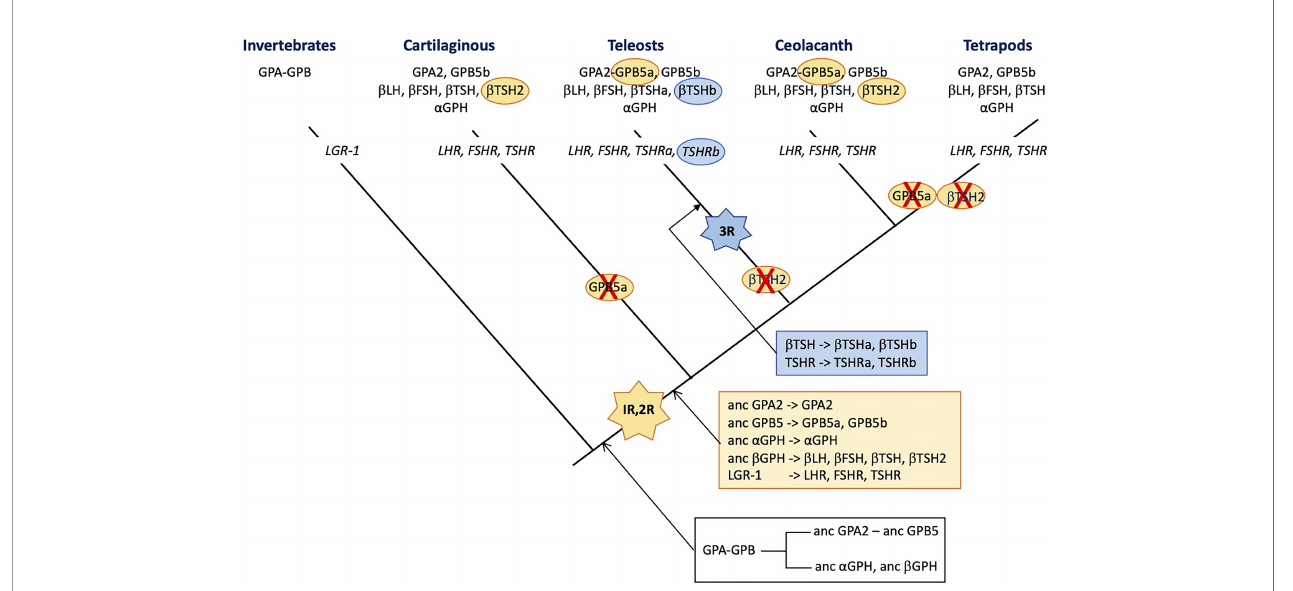
FIGURE 3 | Schematic representation of the distribution of glycoprotein hormone (GPH) subunit-related genes and receptors (in italic) presented on a simpli fi ed phylogenetic tree. The initial tandem duplication of GPA and GPB giving rise to the ancestral forms of GPA2 and GPB5 and of a - and b -GPH just prior to the vertebrate expansion is indicated in the black box underneath the tree. The genes issued from the two rounds of genomic duplication that occurred in founder vertebrates are depicted in the orange box. Those issued from the teleost-speci fi c third round of genomic duplication are presented in the blue box. The hyphen in GPA-GPB and GPA2-GPB5a indicates that the genes are organized in tandem. The red cross indicates loss of the gene. 1R, 2R and 3R represent whole genome duplication events. LH, luteinizing hormone; FSH, follicle stimulating hormone; TSH, thyroid stimulating hormone; GPA, invertebrate representative of the precursor for vertebrate GPA2 and GPH a subunit; GPB, invertebrate representative of the precursor for vertebrate GPB5 and GPH b subunits. GPA2 and GPB5, vertebrate representatives of GPA and GPB, respectively; LGR, leucine-reach repeat receptor; LHR, FSHR and TSHR, receptors for LH, FSH and TSH,